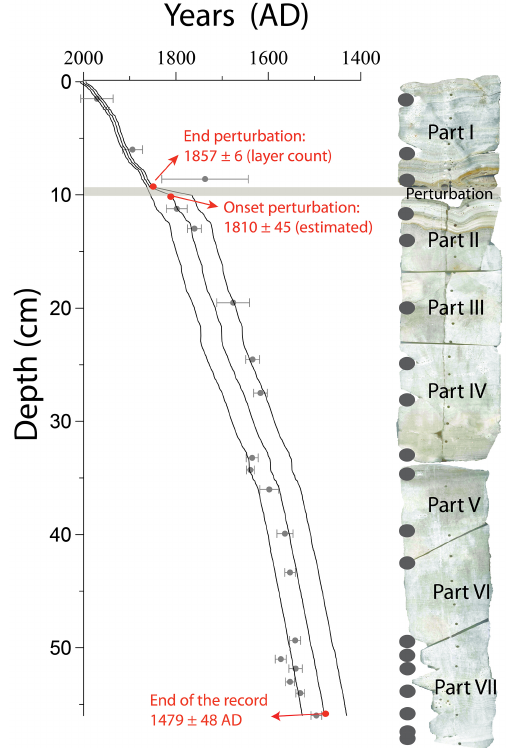
Figure 4. Age–depth model of the Proserpine based on layer- counting ages reported with their 2 σ uncertainty. The onset of the perturbation is estimated by counting the layers back up from the U / Th age located closest below the perturbation. U / Th ages are plotted in light grey in the age–depth graph with their 2 σ uncer- tainty. Location of U / Th samples on the Proserpine core is indi- cated by the black dots. All ages are reported in years AD.